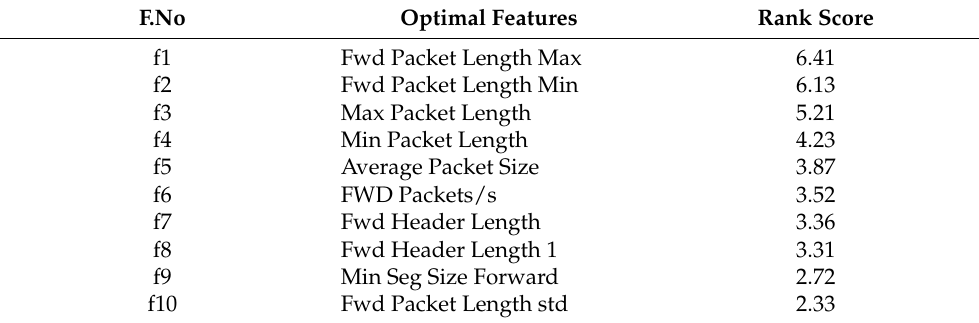
Table 2. Optimal feature set.